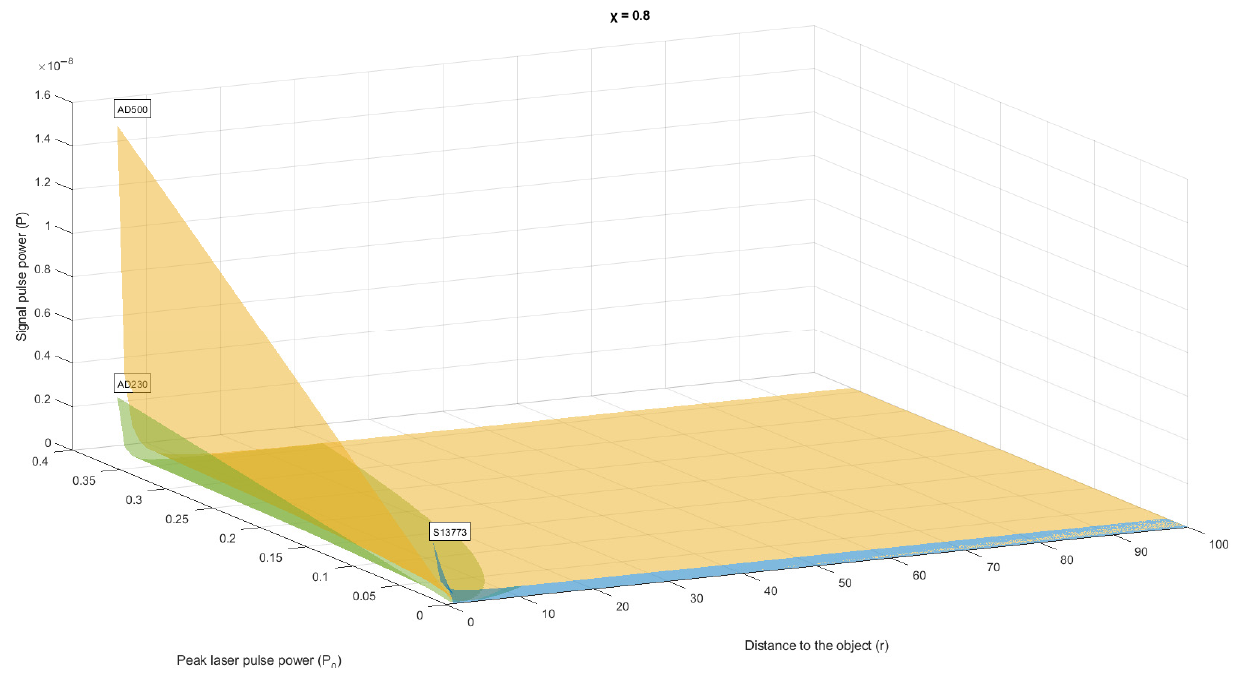
Figure 8. The dependence of the received optical power on the distance and pulse power of the LiDAR for three types of detectors (AD500, AD230 and S13773) in the media with optical loss factor χ 2 = 0.8. The modelled data show the dependence of the received optical power from the distance to the object, taking into account the peak power of the transmitter of the